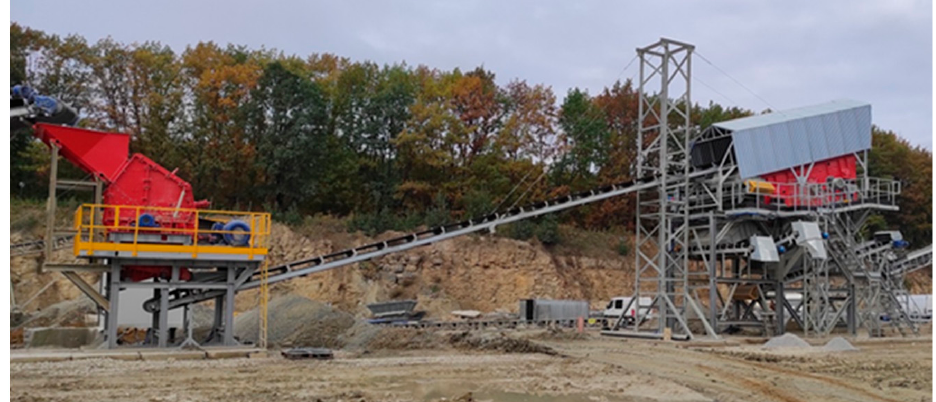
Figure 3. View of the KU 80/120 crusher and the WSR 3-2.0/6.0 screen. Table 2. Characteristics of the KU 80/120 crusher.